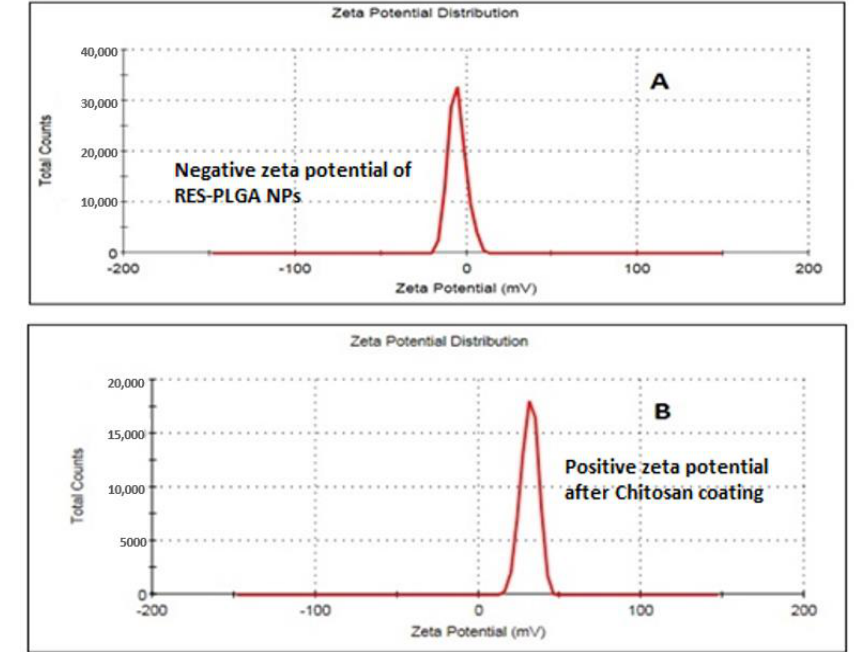
Figure 1. Zeta potential of PLGA nanoparticles (NPs) suspended in PBS (pH = 7.4), ( A ) Resveratrol (RES)-PLGA-NPs; ( B ) Chitosan (CS)-coated RES-PLGA-NPs.